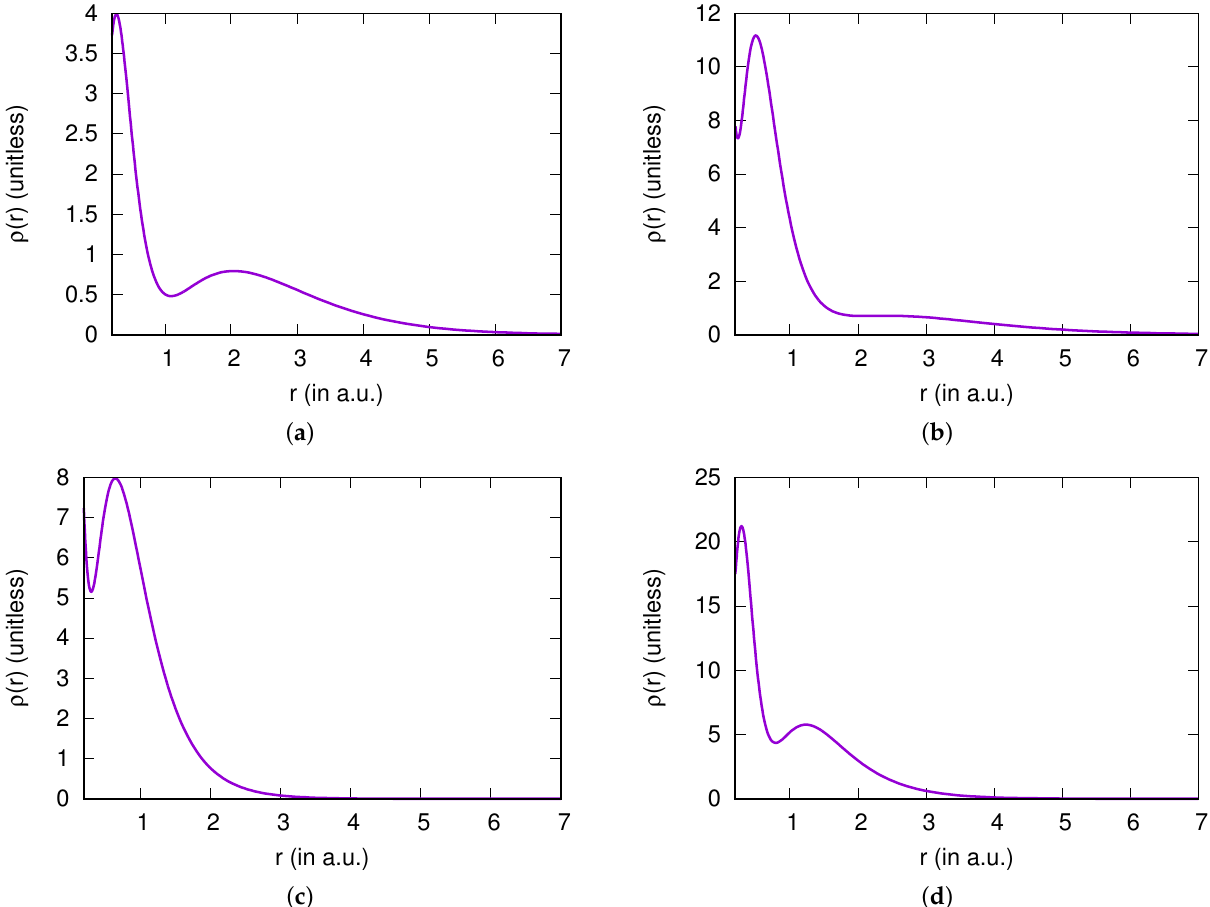
Figure 1. Densityprofiles of ( a ) Be, ( b ) Mg, ( c ) Ne and ( d ) Ar atoms obtained using the DHF method in their ground states. The radial distances (r) are given in atomic units (a.u.), while density values ρ (r) are